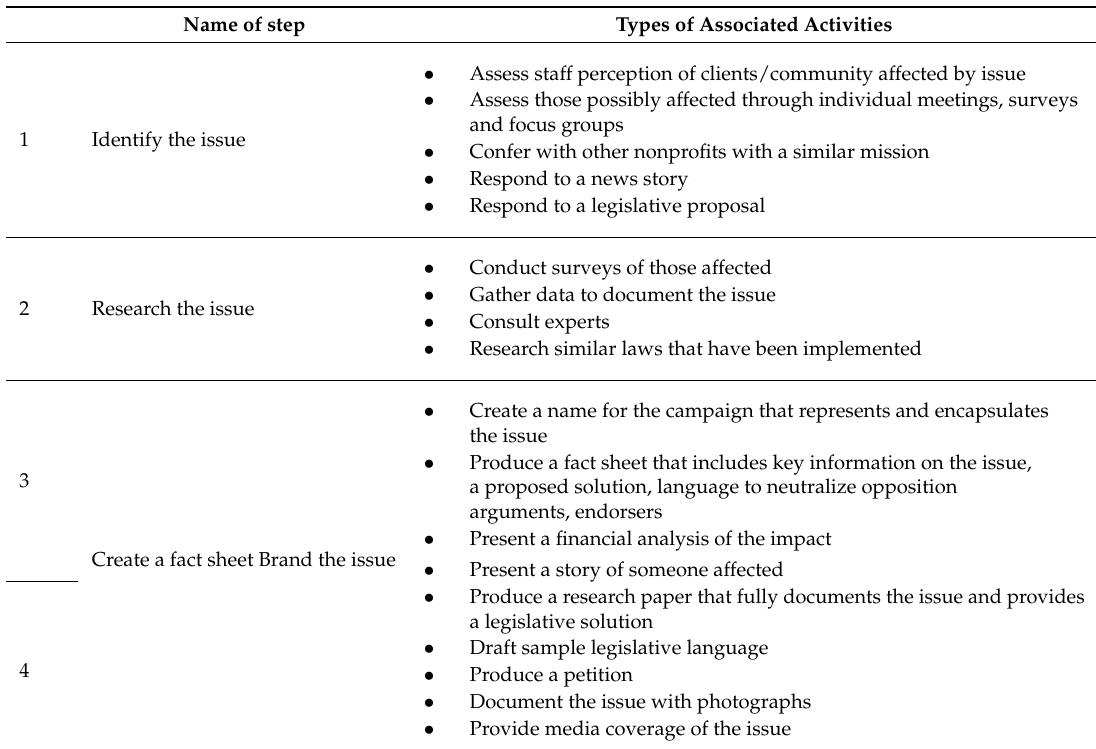
Table 1. Libby Lobbying Model